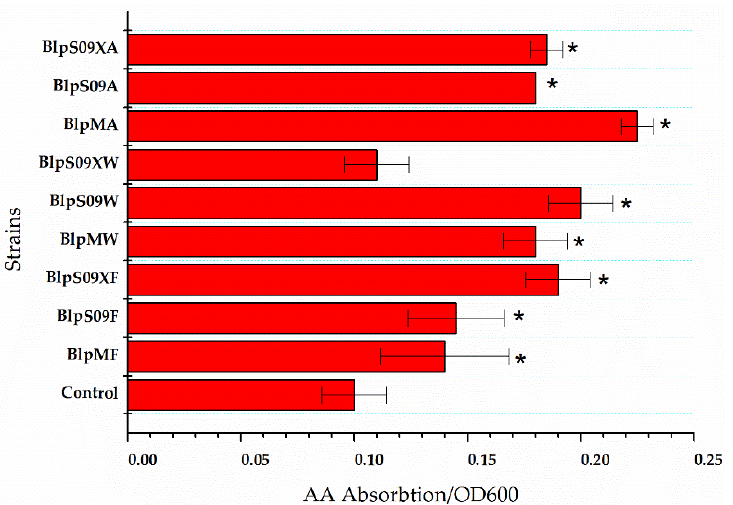
Figure 2. The ratio of extracellular L-aspartic acid concentration to the cell concentration of the strains that overexpressed the amino acid permease. A wild-type strain with plasmid pHY300-PLK was used as the control. Each experiment was repeated at least three times; data are represented as the means of three replicates and bars represent the standard deviations. * p < 0.05 indicates the significance levels between the recombinant strains and the control strain.